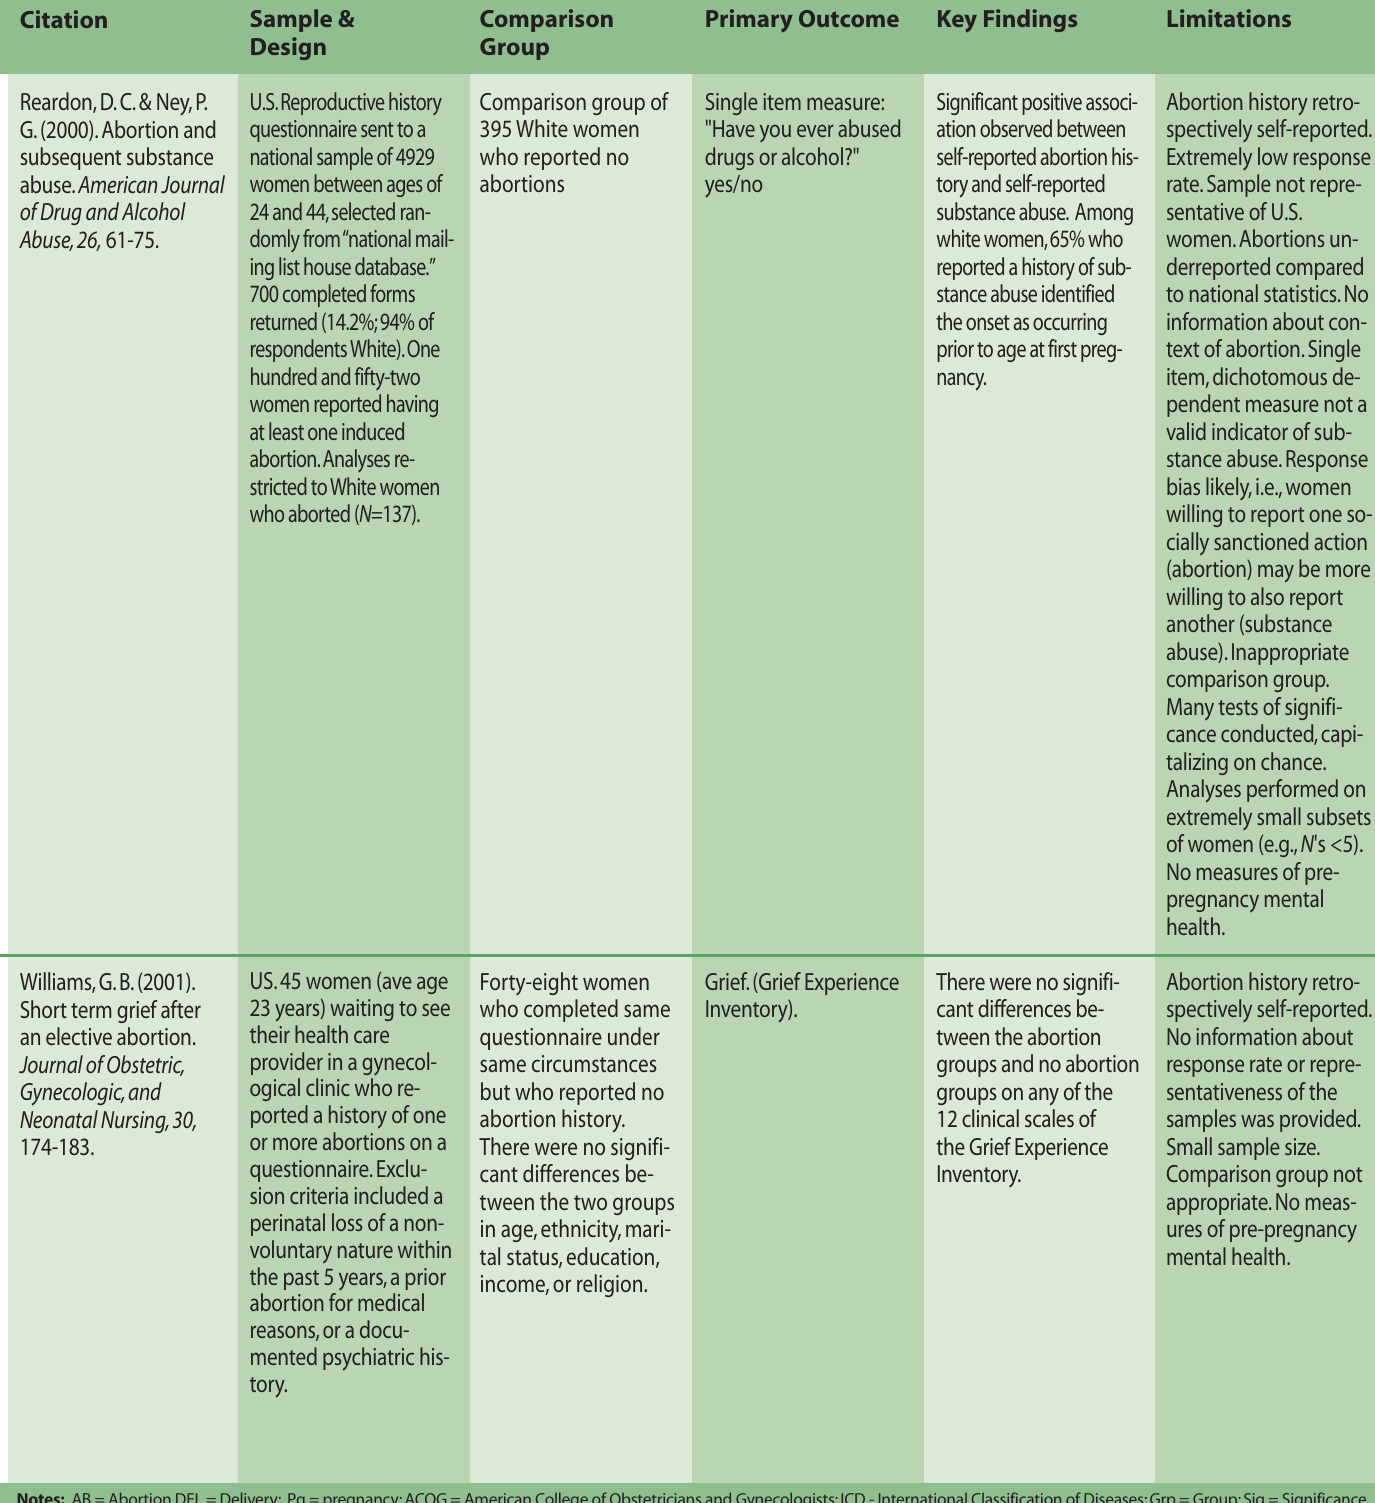
Table 3A: Primary Data Comparison Group Studies UNITES STATES SAMPLES (continued)